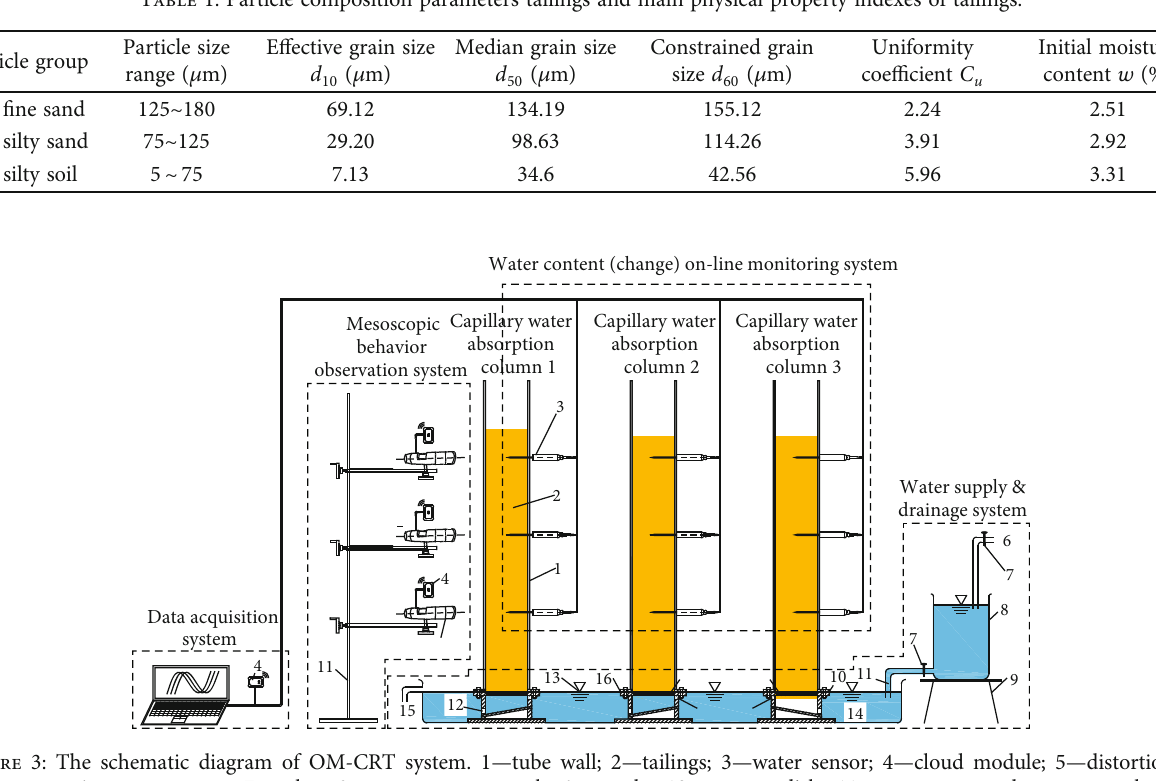
Figure 2: The cumulative particle distribution curve of Table 1: Particle composition parameters tailings and main physical property indexes of tailings.